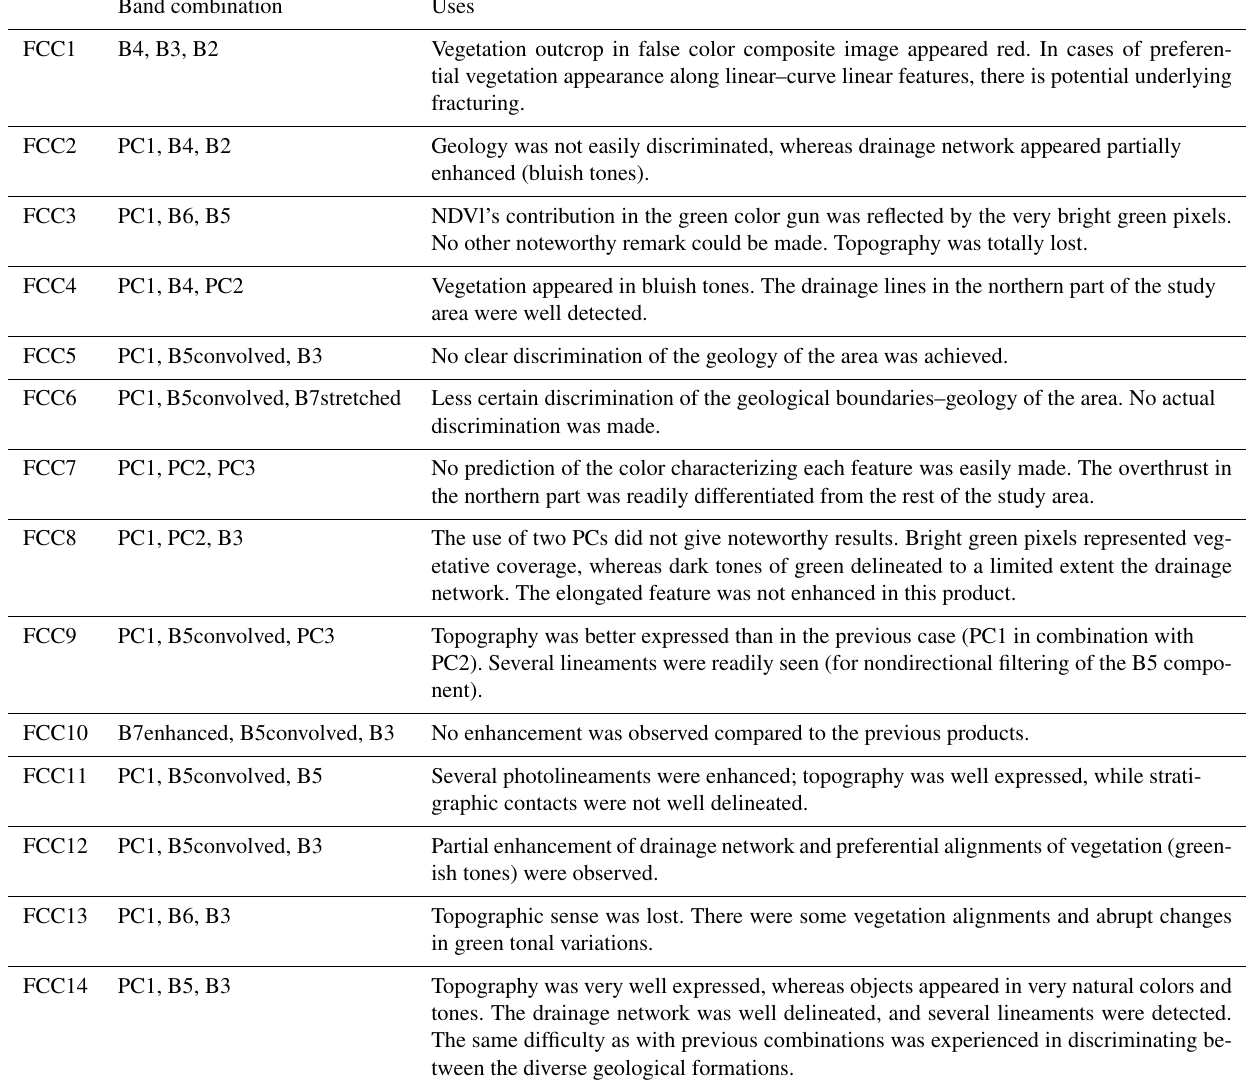
Table 2. False color